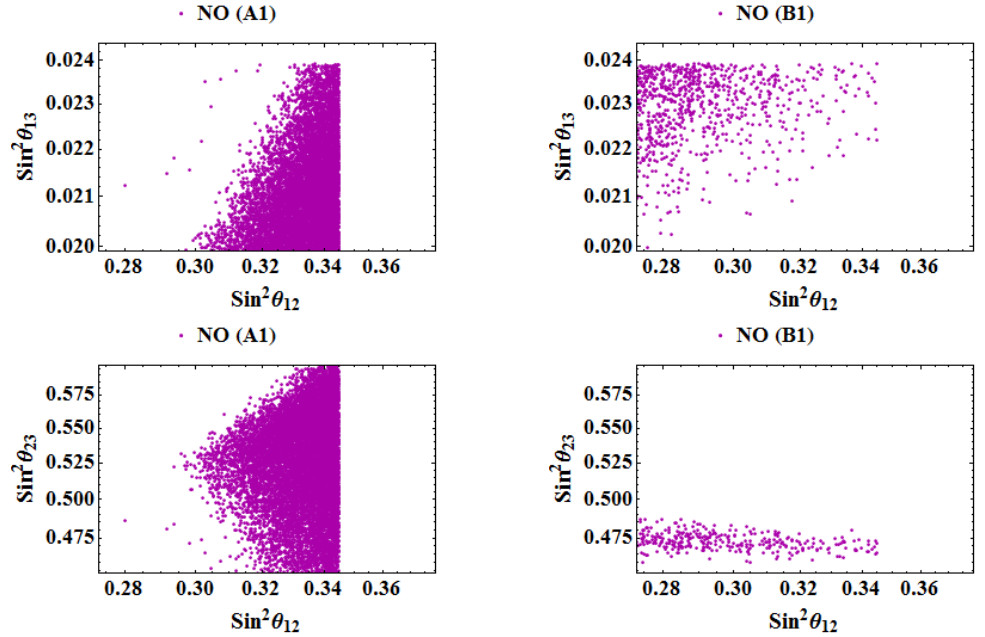
Figure 5 . Correlation between light neutrino parameters in NO case. allowed to be even smaller than the heaviest right-handed neutrino mass.